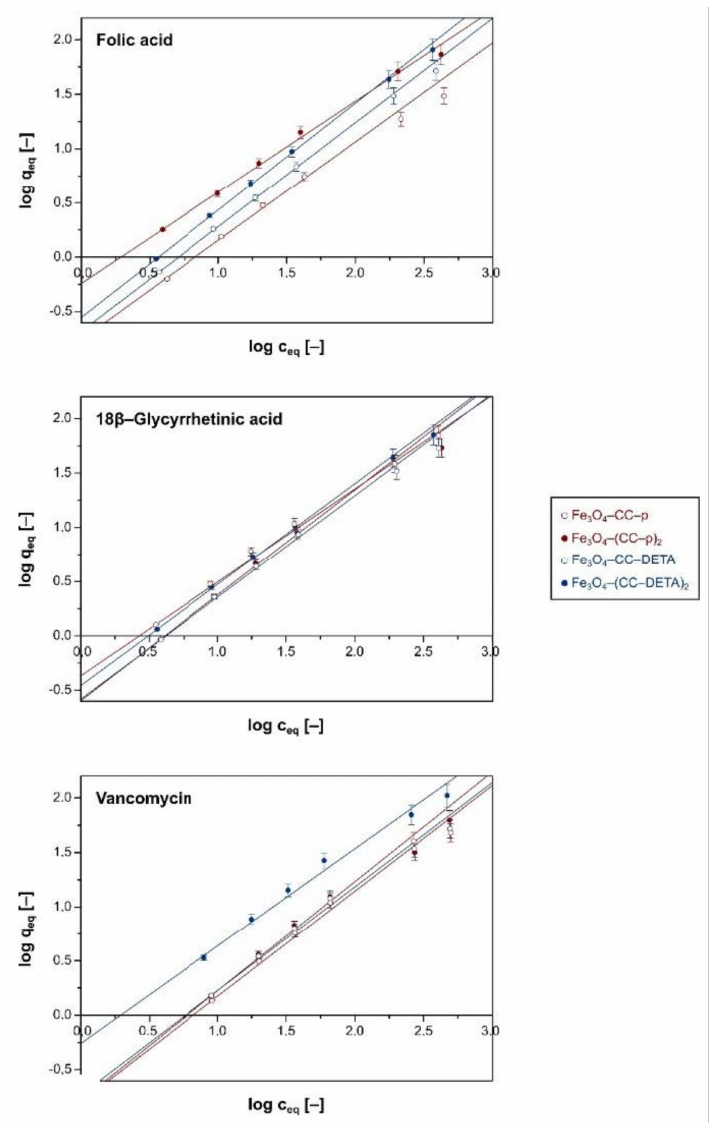
Figure 6. The fitting of the experimental data of the adsorption of the biomolecules on the surface of the dendron-functionalized hybrid materials by the Freundlich